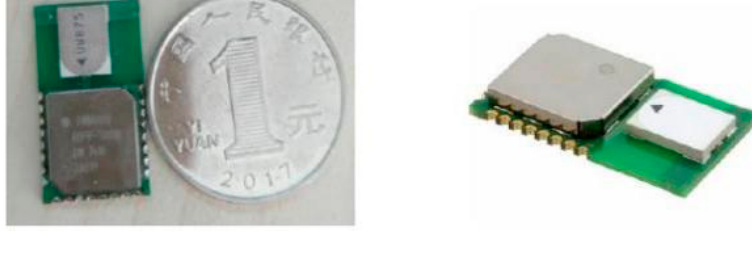
Figure 7. DWM1000.